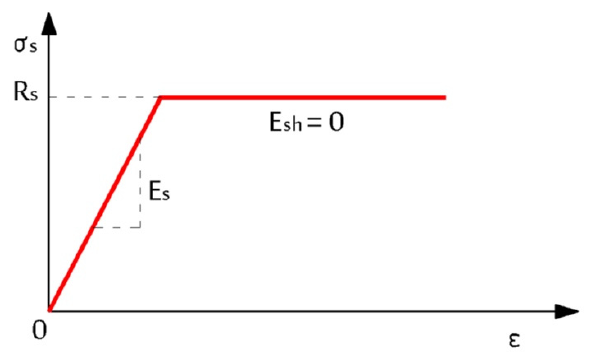
Figure 12. Bilinear stress–strain diagram of the steel.